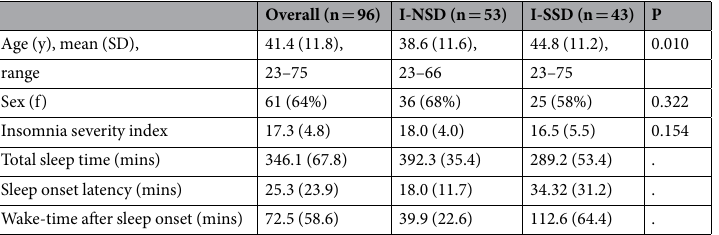
Table 1. Means (standard deviations) and N (proportion) for demographic, sleep parameters (used to cluster individuals) and clinical features of the sample. Note: Total sleep time, sleep onset latency and wake-time after sleep onset are different by design of the cluster groups and are not tested for statistical significance. CBT: cognitive behaviour therapy; I-NSD: Insomnia with normal sleep duration; I-SSD: Insomnia with short sleep